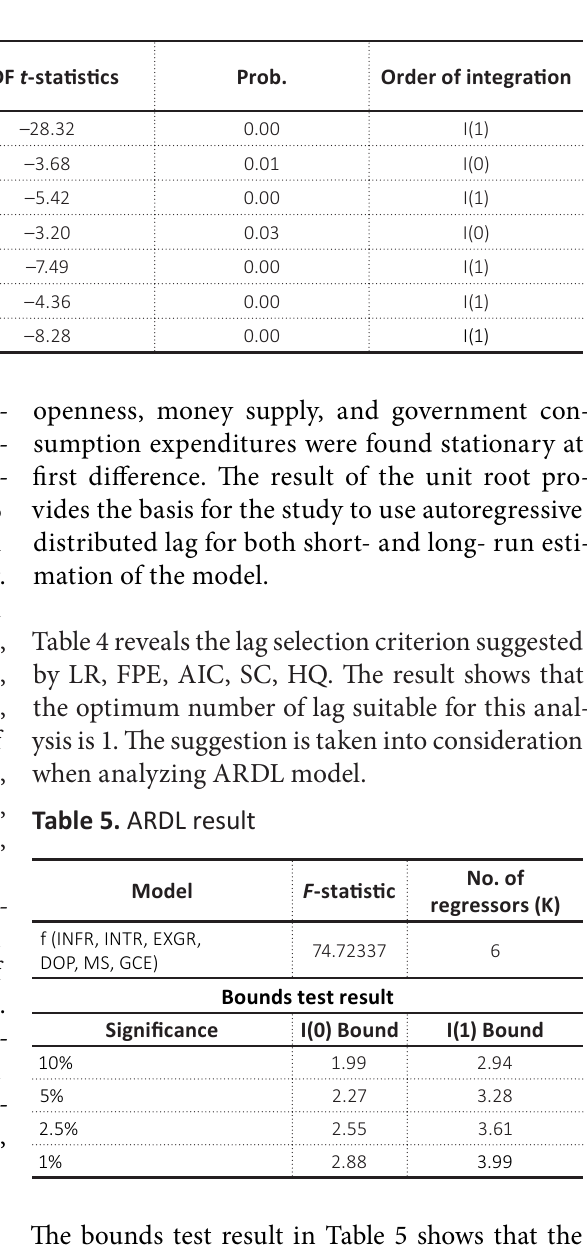
Table 3. Unit root test of ADF